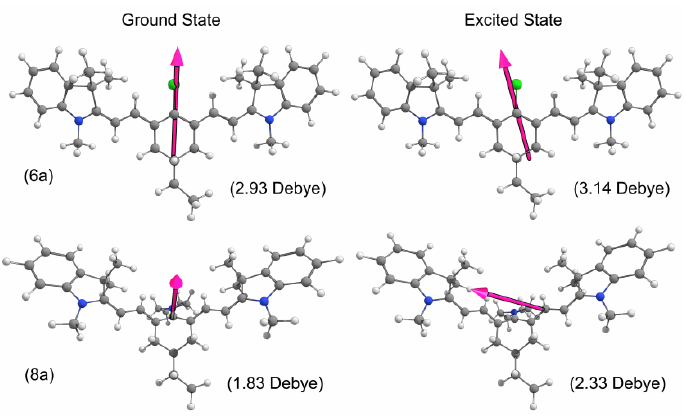
Figure 5. ( a ) Lowest and more stable conformers for cyanine dyes 6a and 8a , and ( b ) relative energy distribution of every unique conformer on its respective chemical space.